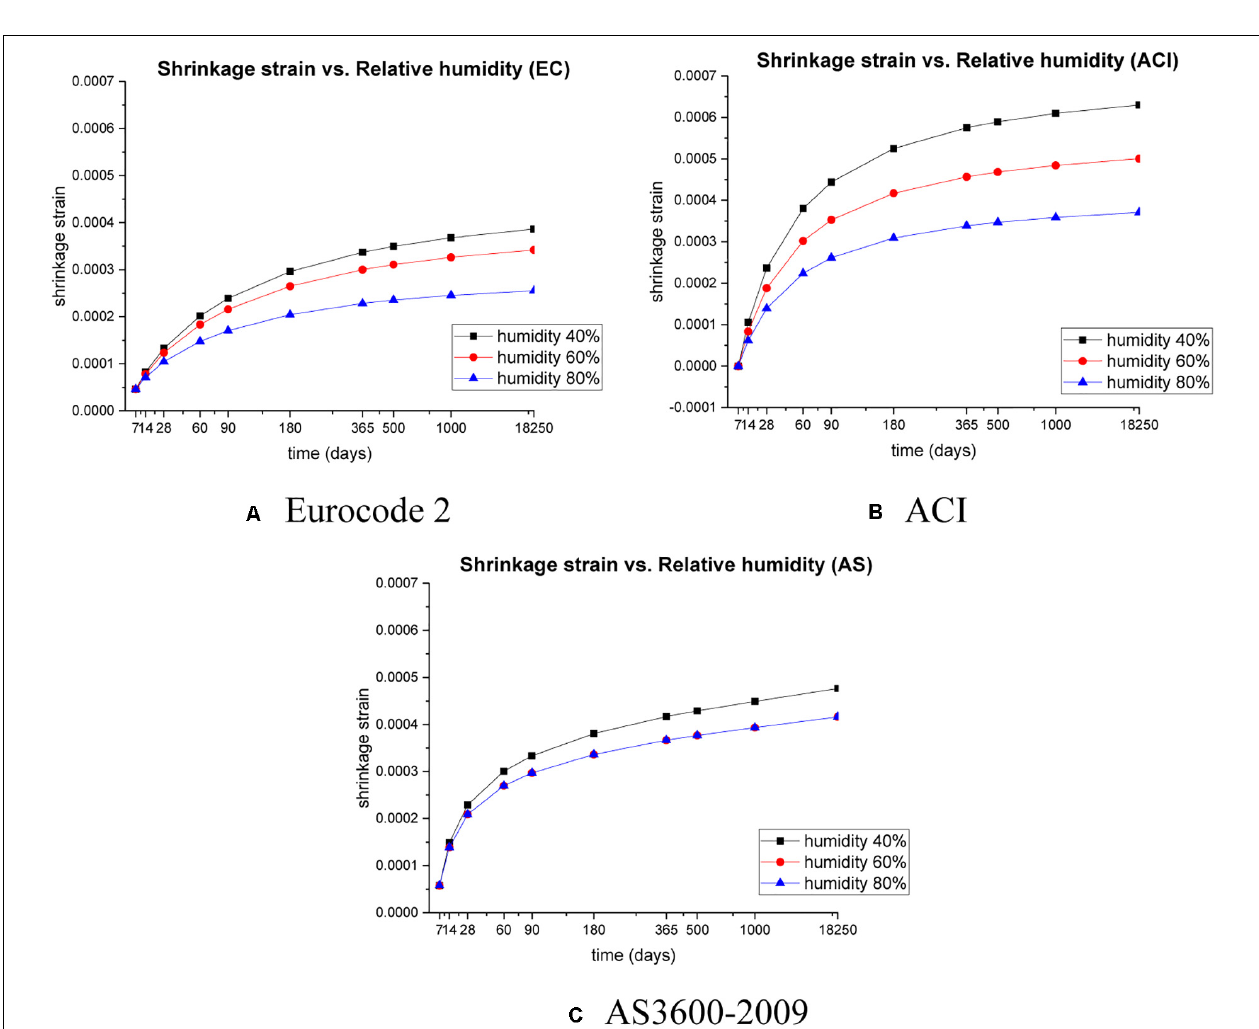
FIGURE 6 | Relative humidity–shrinkage relationship. (A) Euro Code 2, (B) ACI and (C) AS3600-2009.